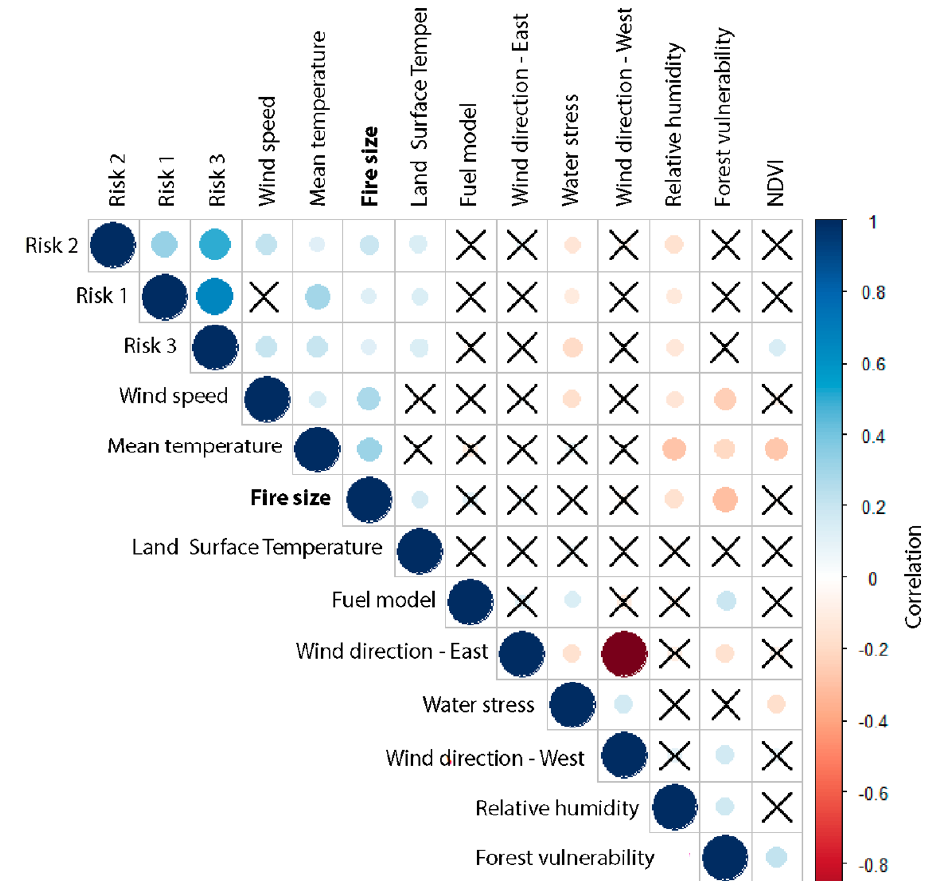
Figure 3. Correlation matrix of variables (significance level for Pearson lower than 0.05; X not sig- nificant).